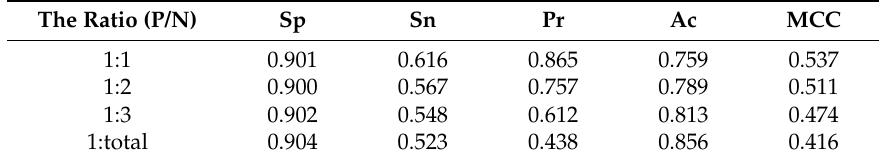
Table 1. The performance of the proposed models trained with different positive versus negative samples ratios based on 10-fold cross-validation (CV) test. MCC—Matthews correlation coefficient.